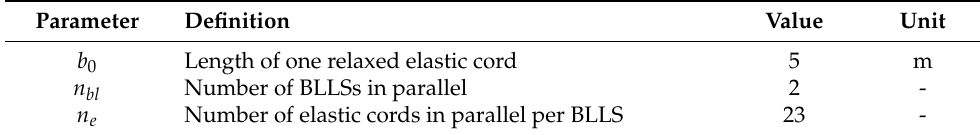
Table 6. The characteristics of the acceleration BLLS.